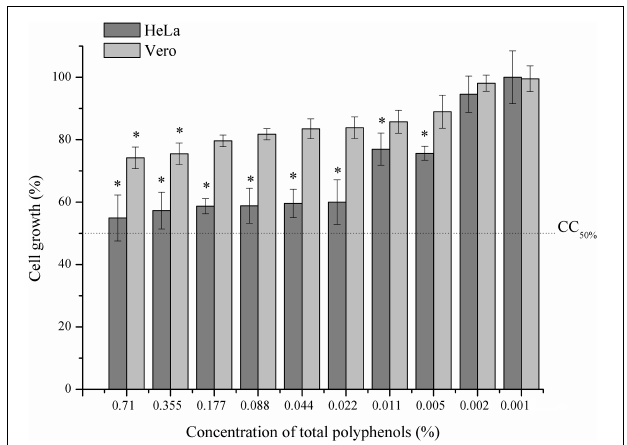
FIGURE 2 | Effect of propolis extract (PE) on HeLa and Vero cell lines. Viability determined by MTT assay. Concentrations of the PE extract ranged from 0.002 to 1.42% of total polyphenols. The results are presented as the average of three independent experiments performed in three replicates, ∗ p < 0.05 compared to control group.